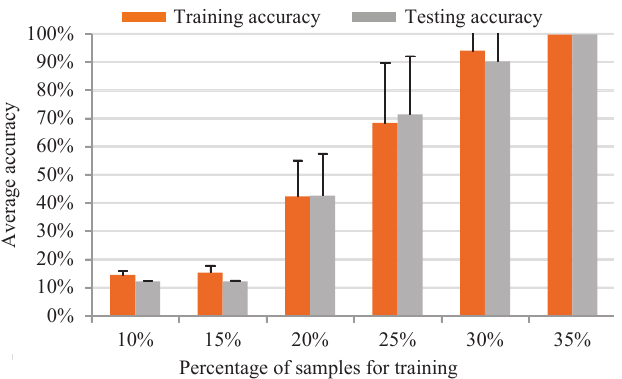
Figure 9. The classification results of the IRT–CNN trained by different percentages of data